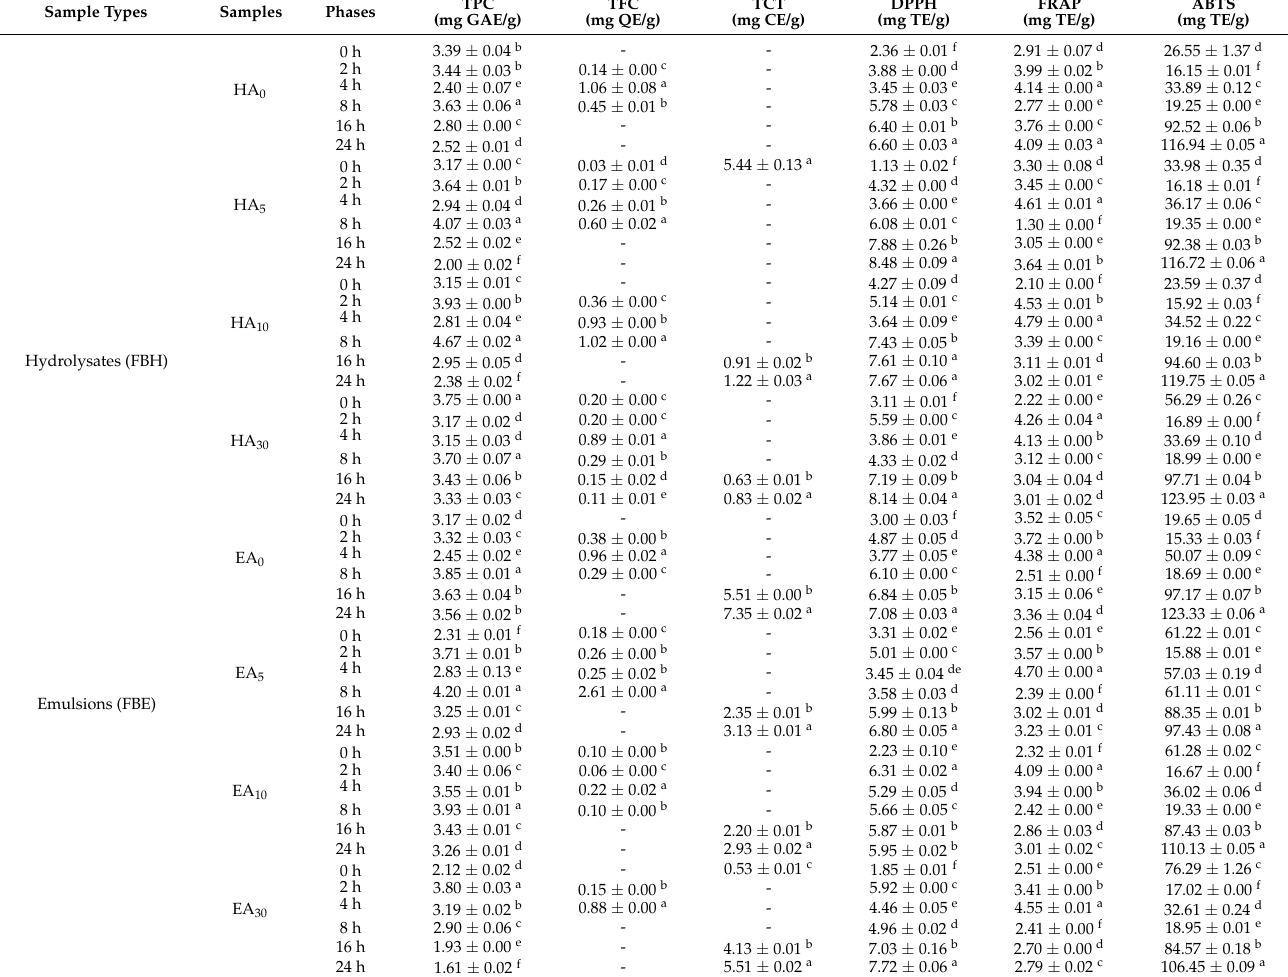
Table 4. Phenolic estimations of faba bean (FB), protein concentrate (FBPC), hydrolysates (FBH) and emulsions (FBE) across colonic fermentation